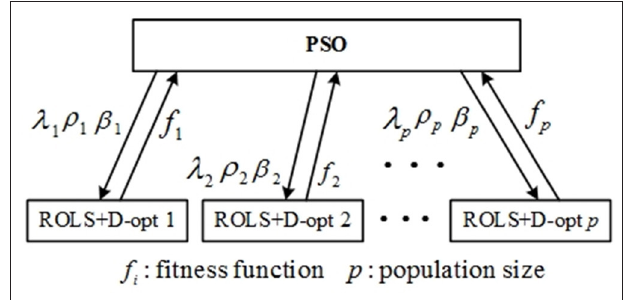
FIGURE 4 | The architecture of two-level learning hierarchy in radial basis function networks.